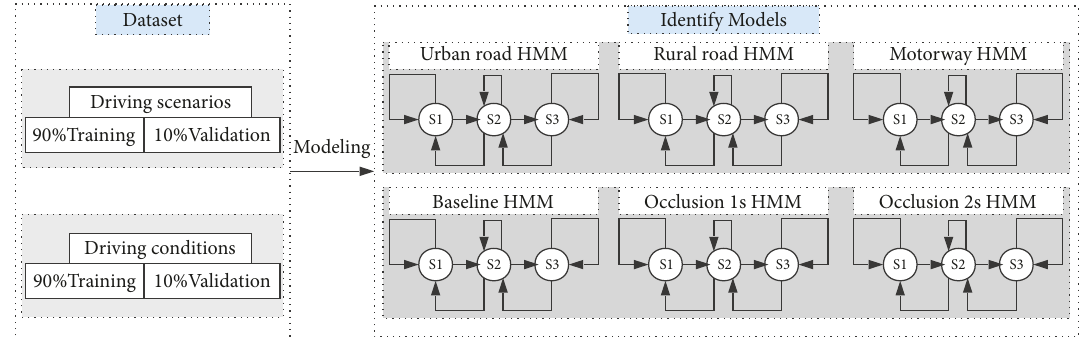
Figure 2: The framework of driving scenarios identification and eyes-off-road durations prediction.